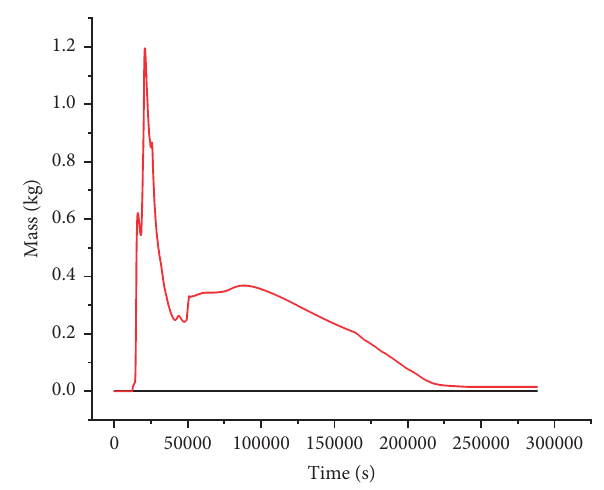
Figure 11: Release of CsI in the primary circuit system.